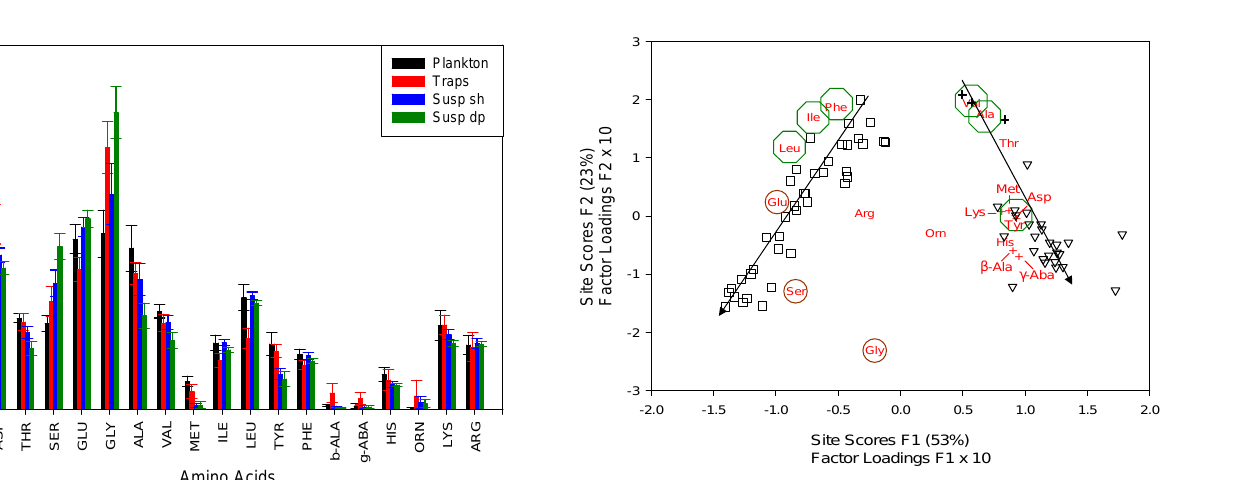
Fig. 4. AA distribution in Mol% averaged for plankton, suspended matter from the mixed layer (Susp sh), deeper waters (Susp dp) and sediment trap samples (from Haake et al., 1992, 1996).